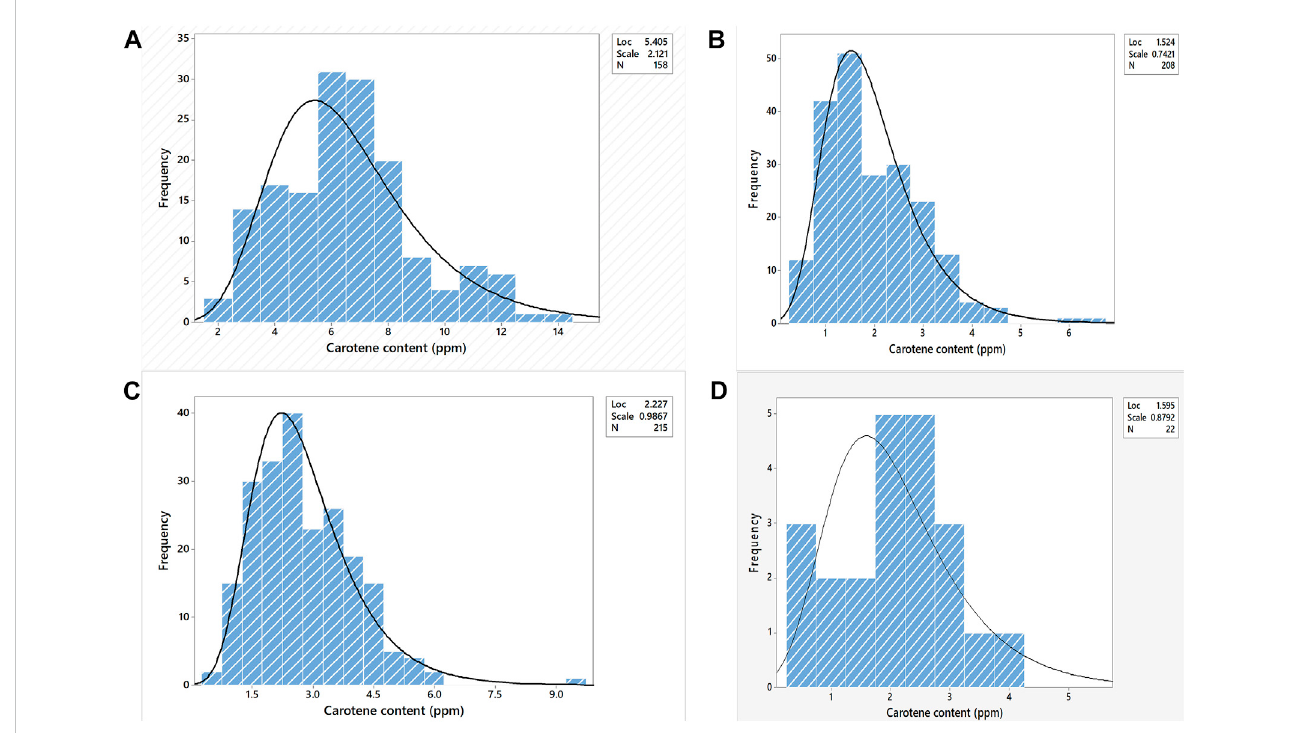
FIGURE 2 FrequencydistributionofcarotenoidcontentintheF2populationofthecross (A) .BC 1 F 5 154XF 6 3, (B) .BC 1 F 5 23XF 6 3, (C) .BC 1 F 5 20XF 6 3, (D) .BC 1 F 5 18X F 6 3 where “ Loc ” (location) speci fi estheMean, “ Scale ” speci fi estheStandard Deviation, and “ N ” speci fi esthenumber ofindividuals taken